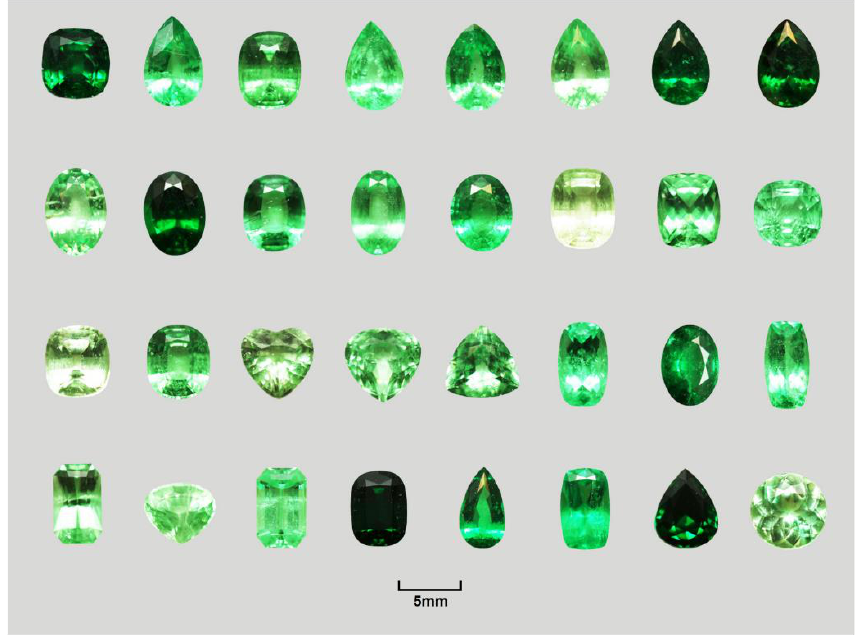
Figure 1. Part of the tsavorite sample with different tones used in this study.